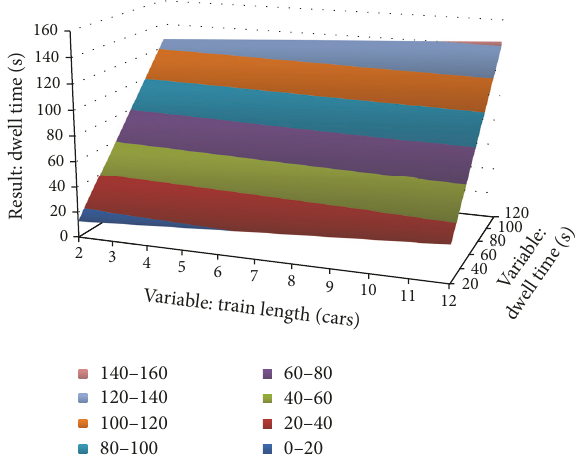
Figure 8: The results from changing the variables in the Dutch railway stations.